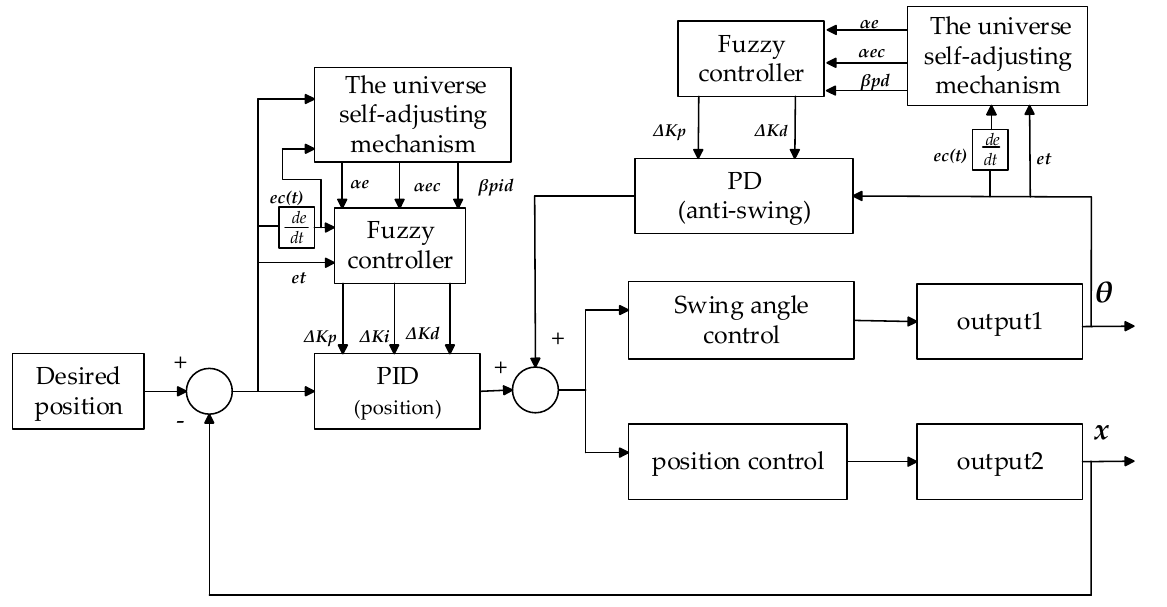
Figure 2. The control scheme for the bridge crane.